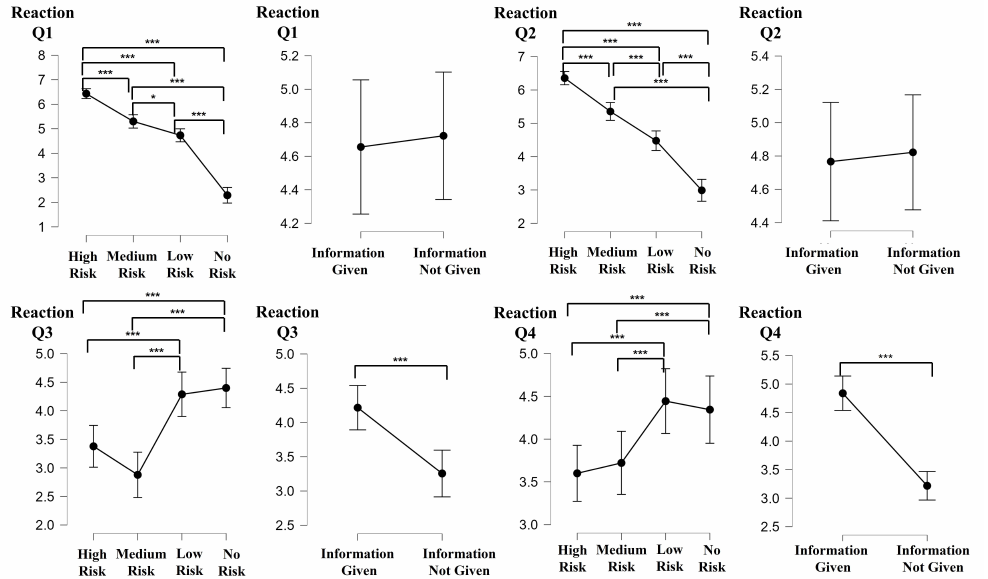
Figure 10. A graph that compares reaction to events questionnaire data according to risk level and whether or not information was provisioned through HUD. The use of asterisks in the figure indicates statistical significance. A single asterisk (*) denotes a p -value less than 0.05, while three (***) asterisks denote p -values less than 0.001,